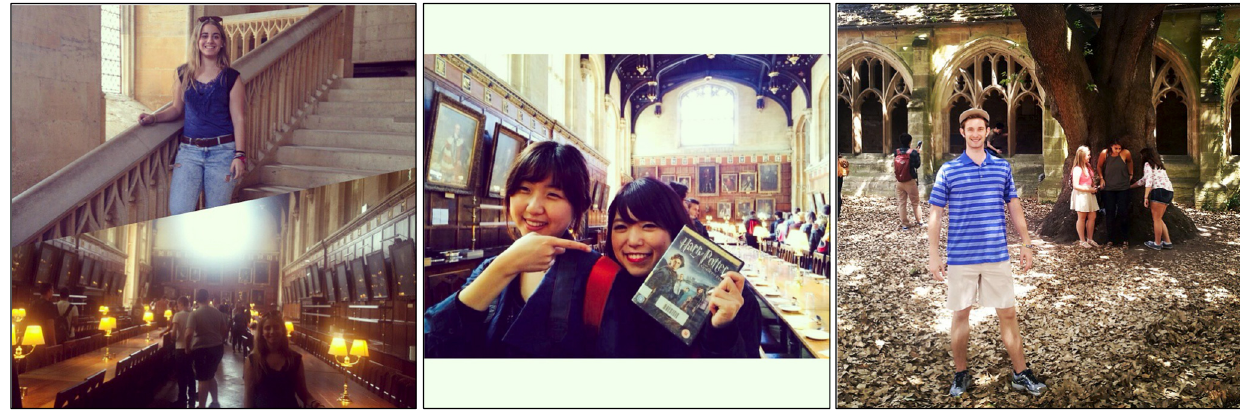
Figure 3. Instagram photos posted by Harry Potter fans in Oxford